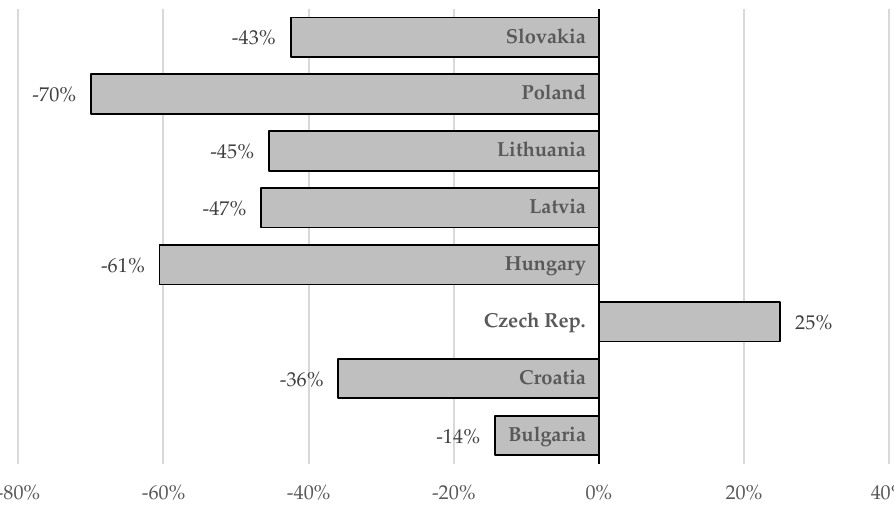
Figure 4. Change in the number of patients treated in 2021 compared to 2019 in individual countries. None of the countries analyzed see any chance of meeting the WHO targets for removing viral hepatitis from the list of public threats by 2030, unless barriers such as